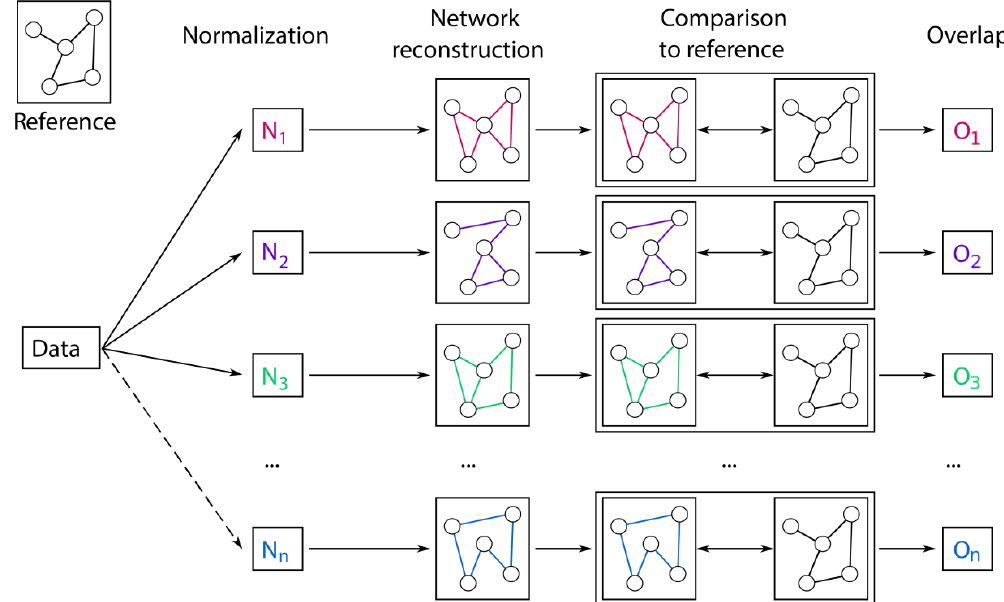
Figure 1. Pipeline for the evaluation of different normalization methods for glycomics data. First, data are normalized with various approaches. From each processed dataset, a Gaussian Graphical Model (GGM) is inferred and compared to the known biochemical pathway of glycan synthesis. The result of this comparison is a quantitative overlap value that describes how well the estimated GGM represents known synthesis reactions. This overlap is then used to evaluate the normalization approach, where higher overlap corresponds to a better data normalization.